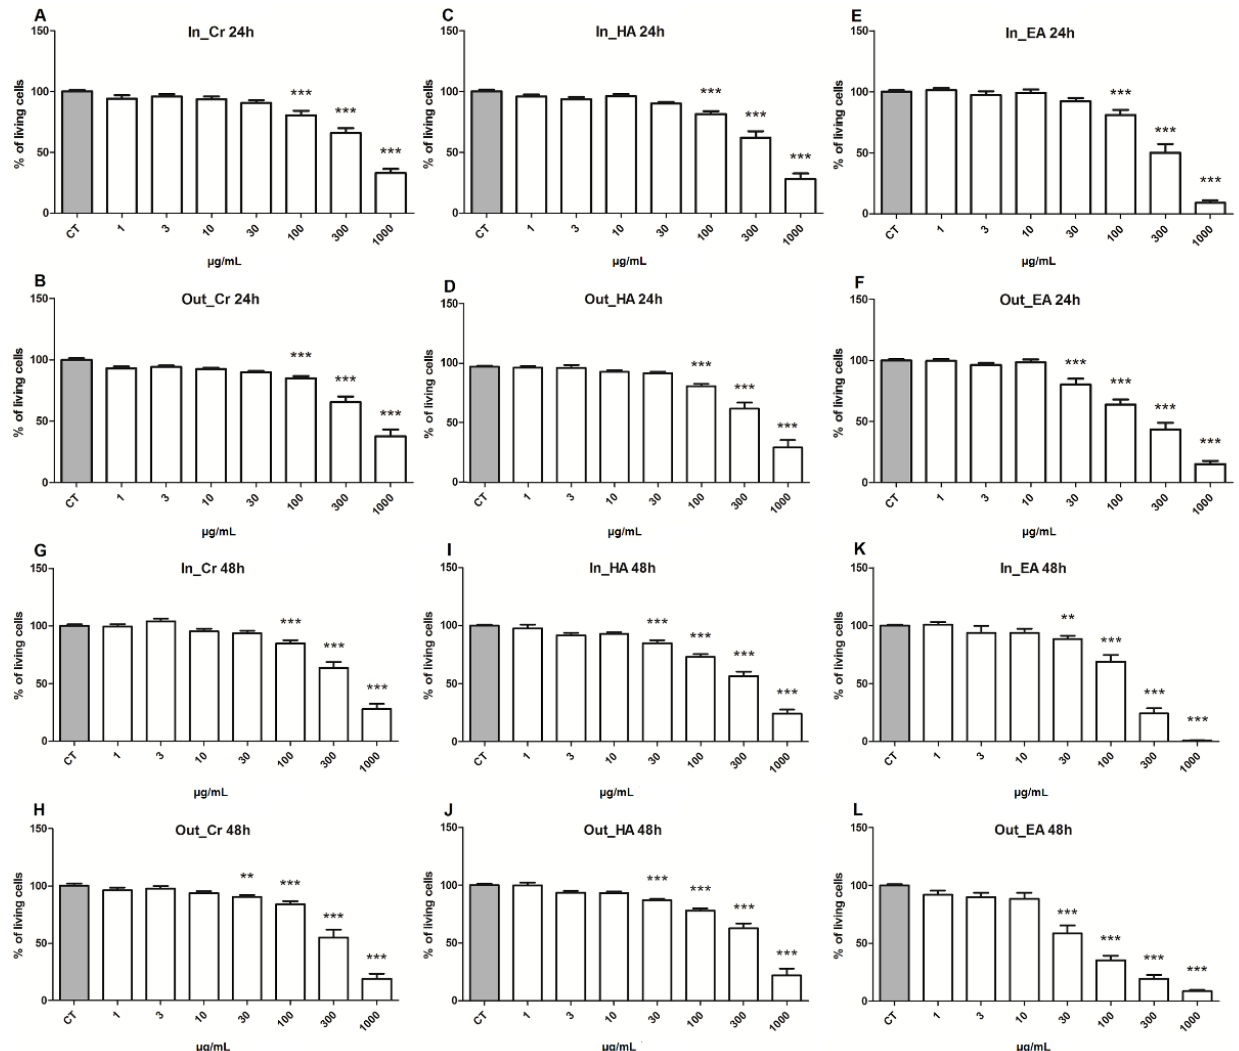
Figure 3. Cytotoxicity of Allium cepa extracts and its fractions after 24 and 48 h of treatment on H295R cell line. ( A , G ) Inner crude extract (In_Cr); ( C , I ) inner hydroalcoholic fraction (In_HA); ( E , K ) inner ethyl acetate fraction (In_EA); ( B , H ) outer crude fraction (Out_Cr); ( D , J ) outer hydroalcoholic fraction (Out_HA); ( F , L ) outer ethyl acetate fraction (Out_EA). CT Control. ** ( p < 0.005); *** ( p < 0.0005) in comparison with respective controls.